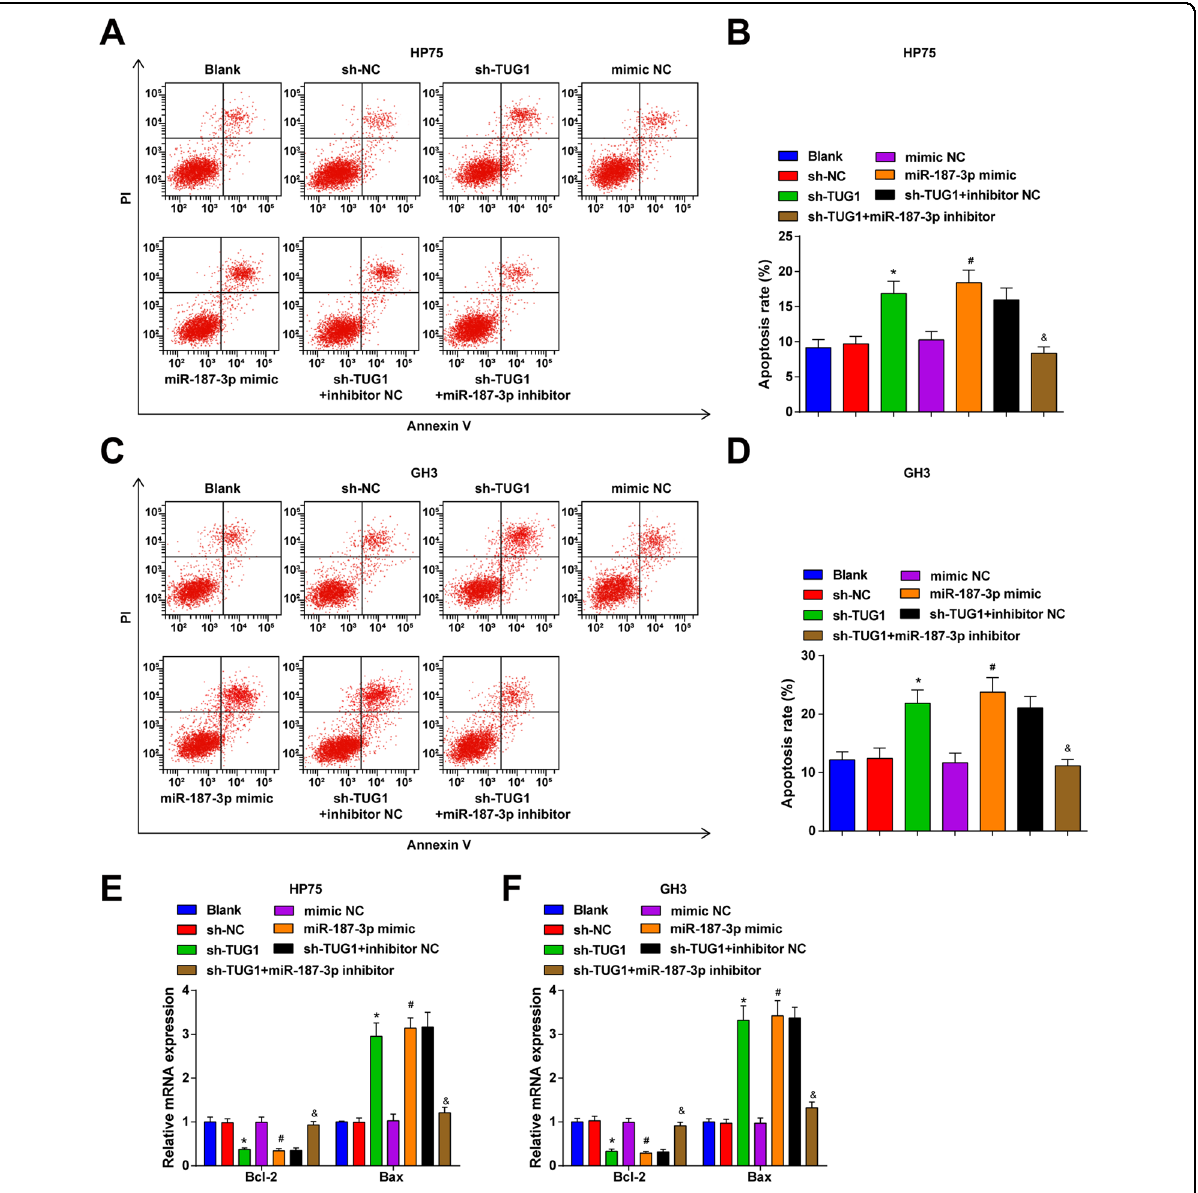
Fig. 4 Inhibited TUG1 or elevated miR-187-3p accelerates apoptosis of PA cells. A apoptosis of HP75 cells was evaluated by fl ow cytometry; B statistical results of apoptosis of HP75 cells; C apoptosis of GH3 cells was evaluated by fl ow cytometry; D statistical results of apoptosis of GH3 cells; E mRNA expression of apoptotic proteins Bcl-2 and Bax in HP75 cells was detected using RT-qPCR; F mRNA expression of apoptotic proteins Bcl-2 and Bax in GH3 cells was detected using RT-qPCR; repetitions = 3. Data are presented as mean ± SD. * P < 0.05 vs the sh-NC group, # P < 0.05 vs the mimic NC group, & P < 0.05 vs the sh-TUG1 + inhibitor NC